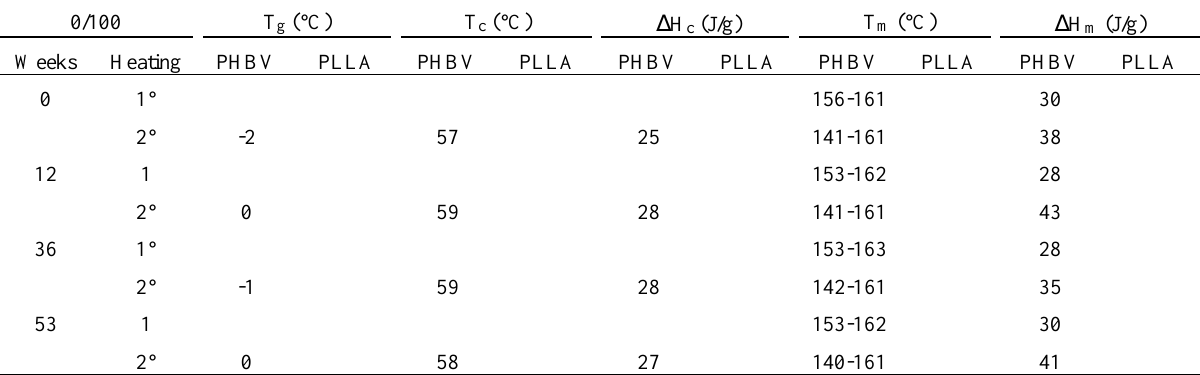
Table 5. Glass Transition (T g ), Crystallization (T c ) and Melting (T m ) Temperatures; Crystallization ( ∆ H c ) and Melting ( ∆ H m ) Enthalpies; obtained by DSC, for films of PLLA/PHBV 0/100 blends in relation to degradation period